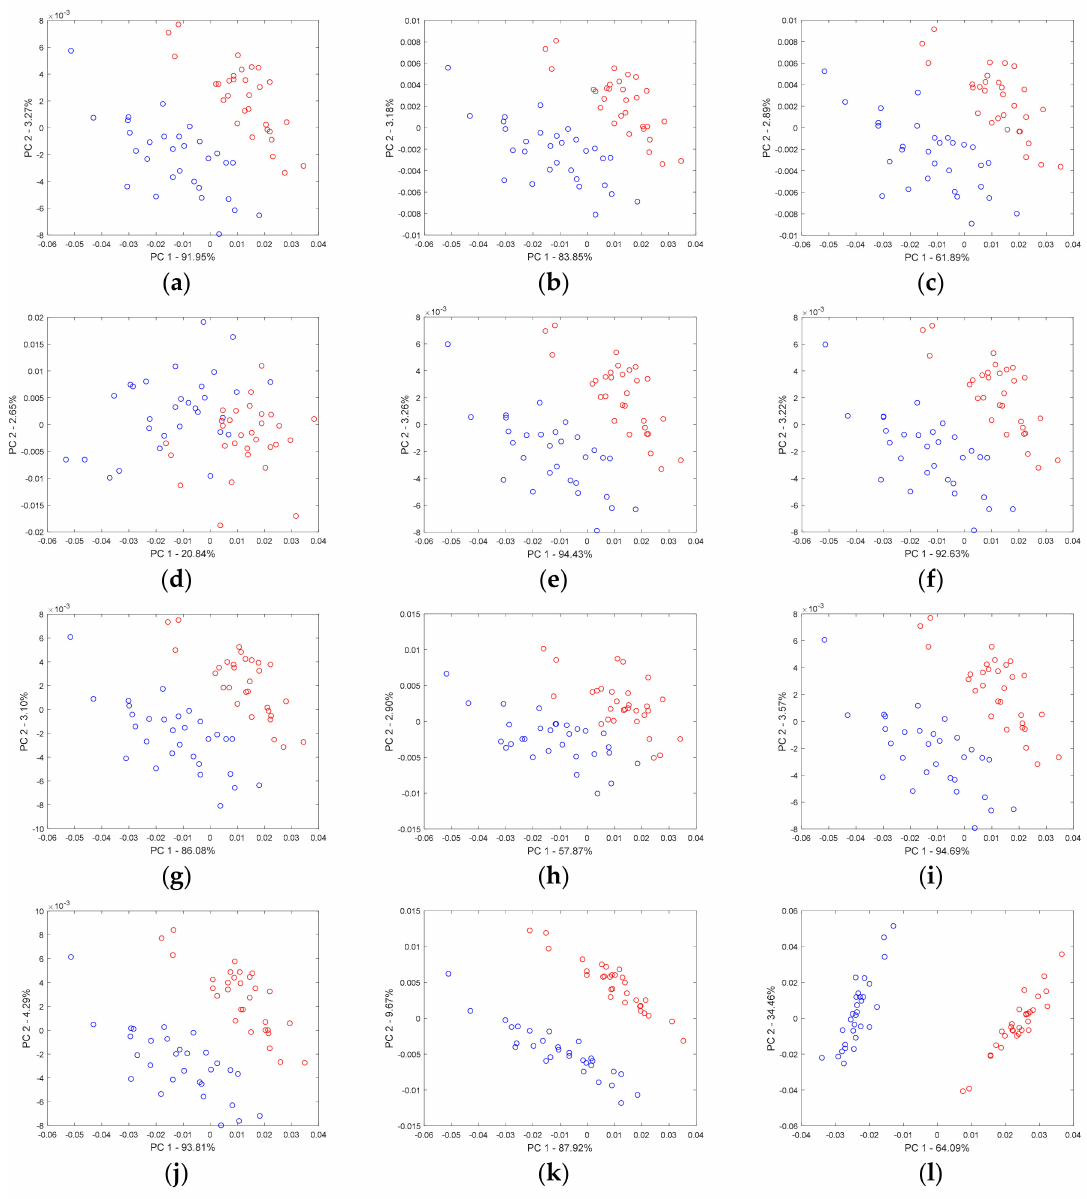
Figure 6. Projections of samples described by one-dimensional chromatograms in the space of the first two principal components: ( a – d ) the increasing level of Gaussian noise (2.27%, 4.54%, 9.08%, and 22.7% concerning the intensity of the largest peak, respectively), ( e – h ) the increasing level of heteroscedastic noise (1.68%, 3.36%, 6.72%, and 16.8% concerning the intensity of the largest peak, respectively), and ( i – l ) increasing level of baseline (0.54%, 1.07%, 2.14%, and 5.35% concerning the intensity of the largest peak,